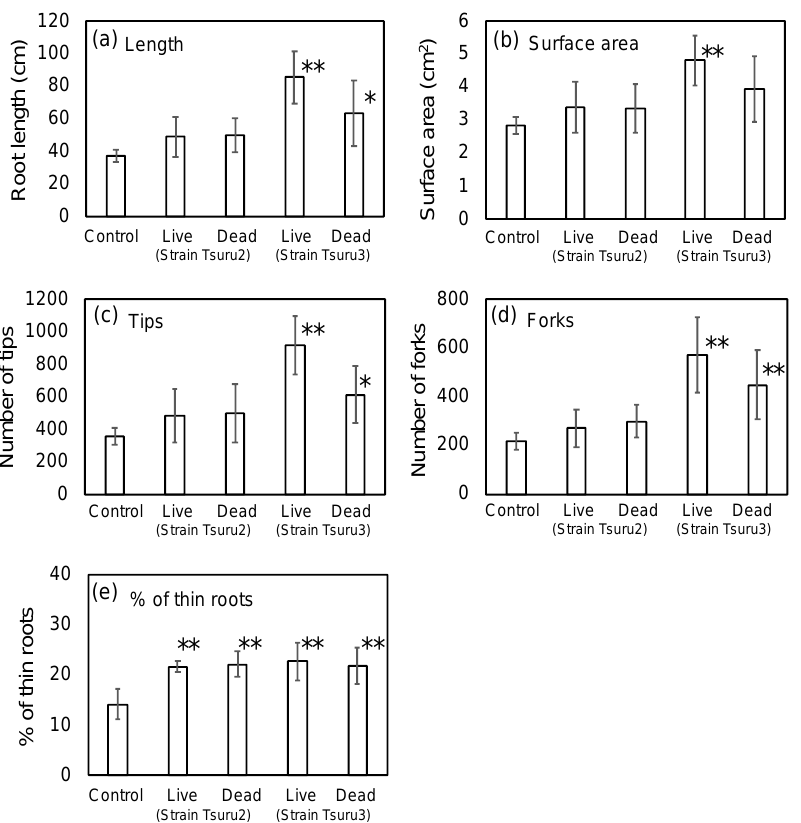
Figure 2. Effect of bio-priming by strains Tsuru2 (live and dead) and Tsuru3 (live and dead) on ( a ) root length, ( b ) surface area, ( c ) number of tips, ( d ) number of forks, and ( e ) % of thin (0.1 mm < diameter) roots. The rice seeds were bio-primed by PNSB for 24 h, sown onto a cell pot and cultivated for 14 days. Data are means ± SD ( n = 5). An asterisk indicates the result that was significantly different (* p < 0.05, ** p < 0.01) from the control.